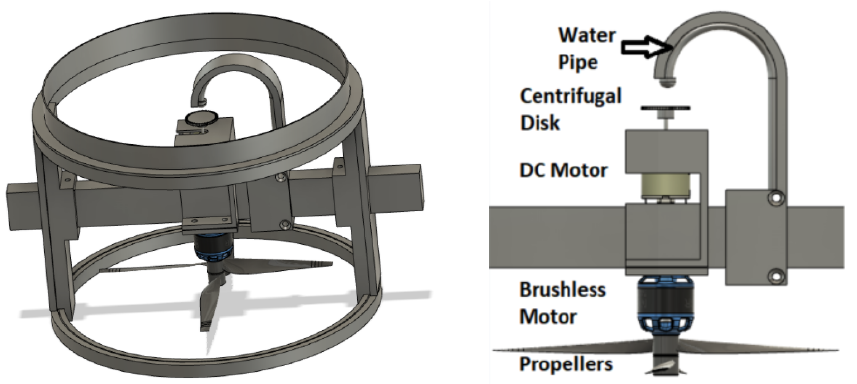
Figure 2. PRYSM sprayer, a spray drum, and 3D model ( left ) and system description ( right ).